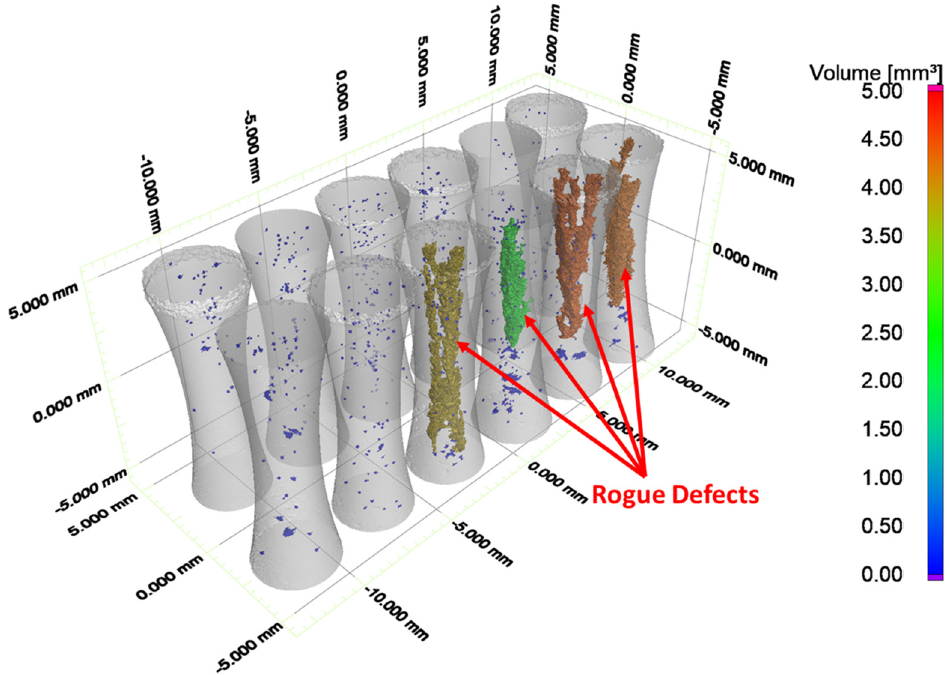
Figure 7. XCT models of machined samples from low-level diameter (3 mm) and highlight of pores with diameter ≥ 0.1 mm. Example “rogue” defects are highlighted. Diameter is defined by the minimum encompassing sphere, which is the longest linear dimension of the pore.